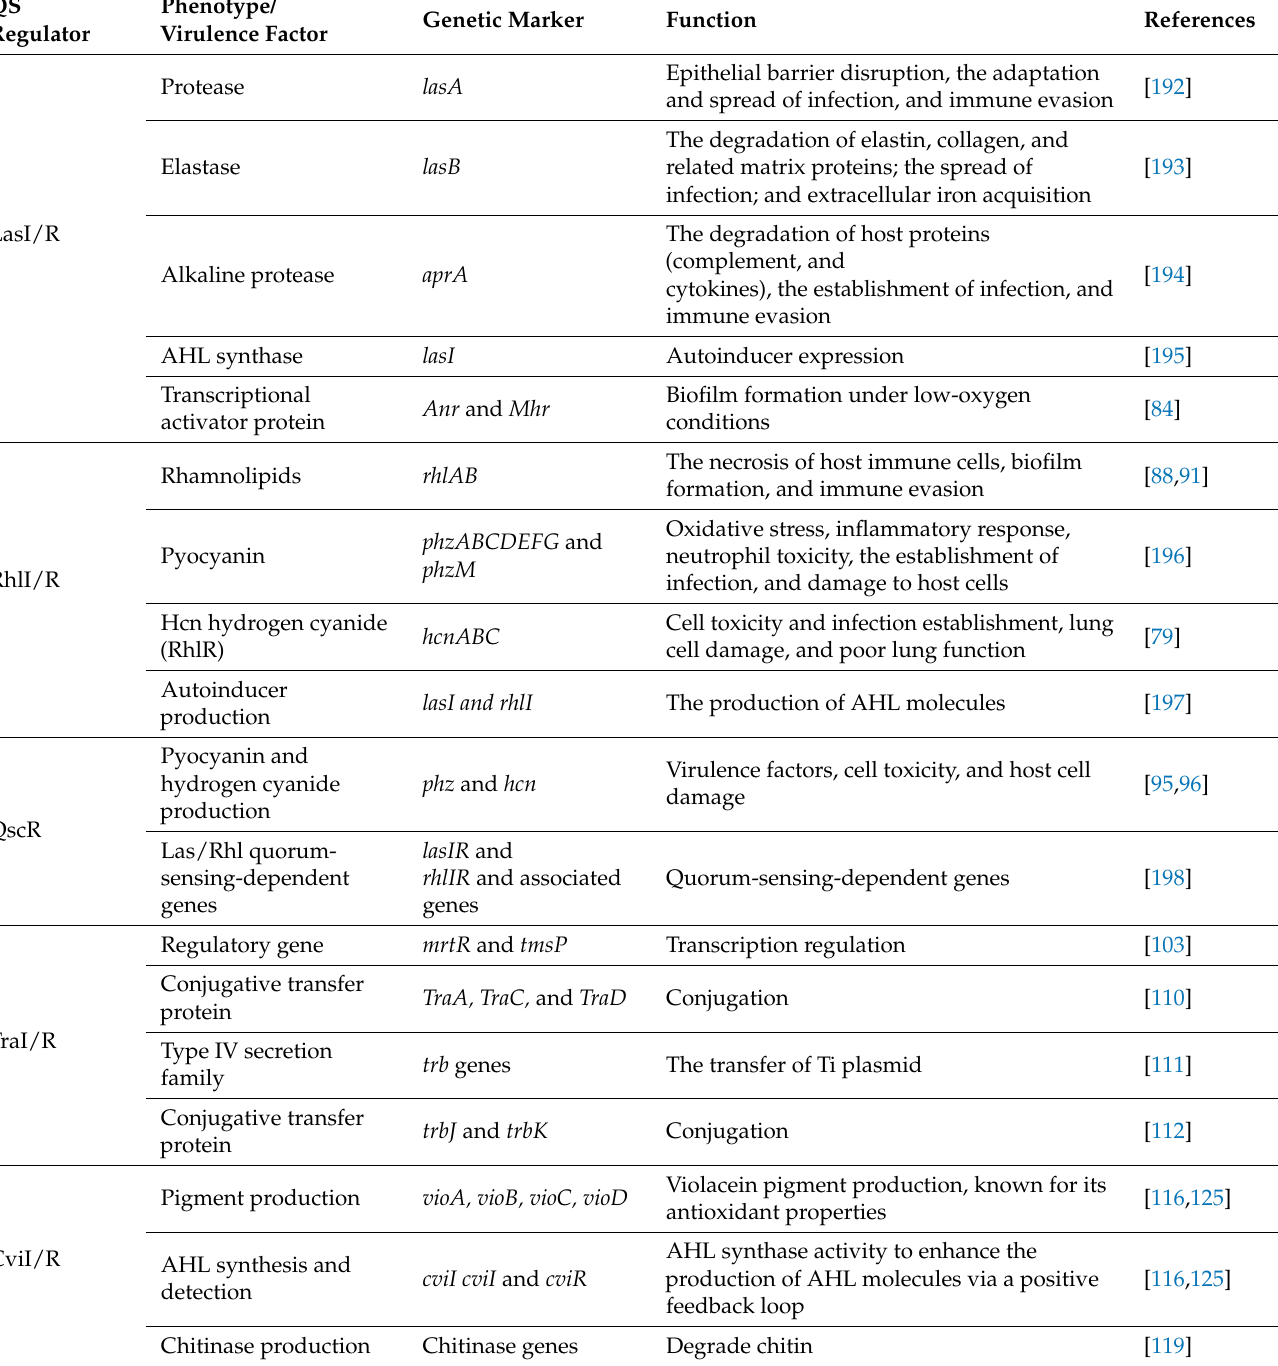
Table 2. The transcriptional regulators, associated virulence factors, and functions of QS regulatory